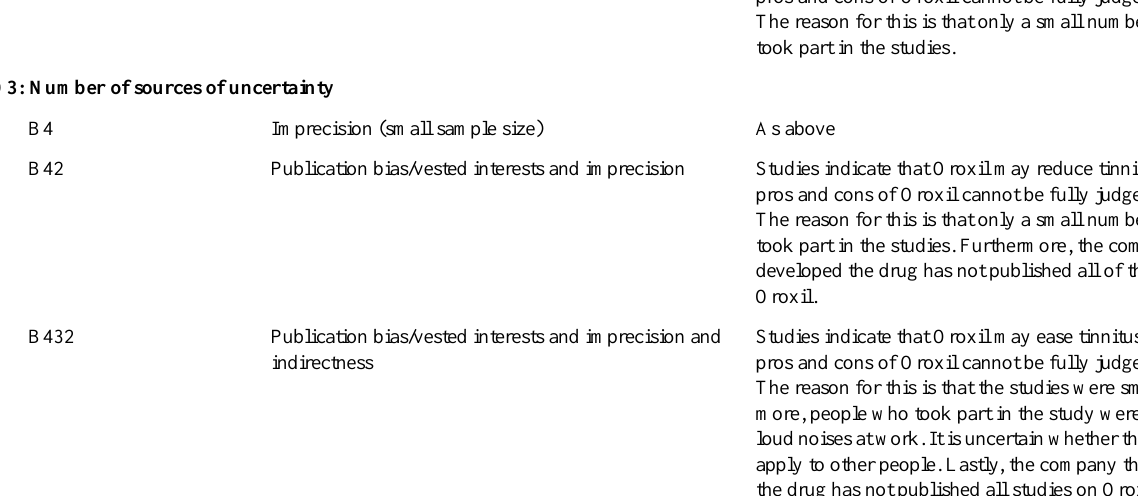
Variations in the textVariations examinedQuestions, Group